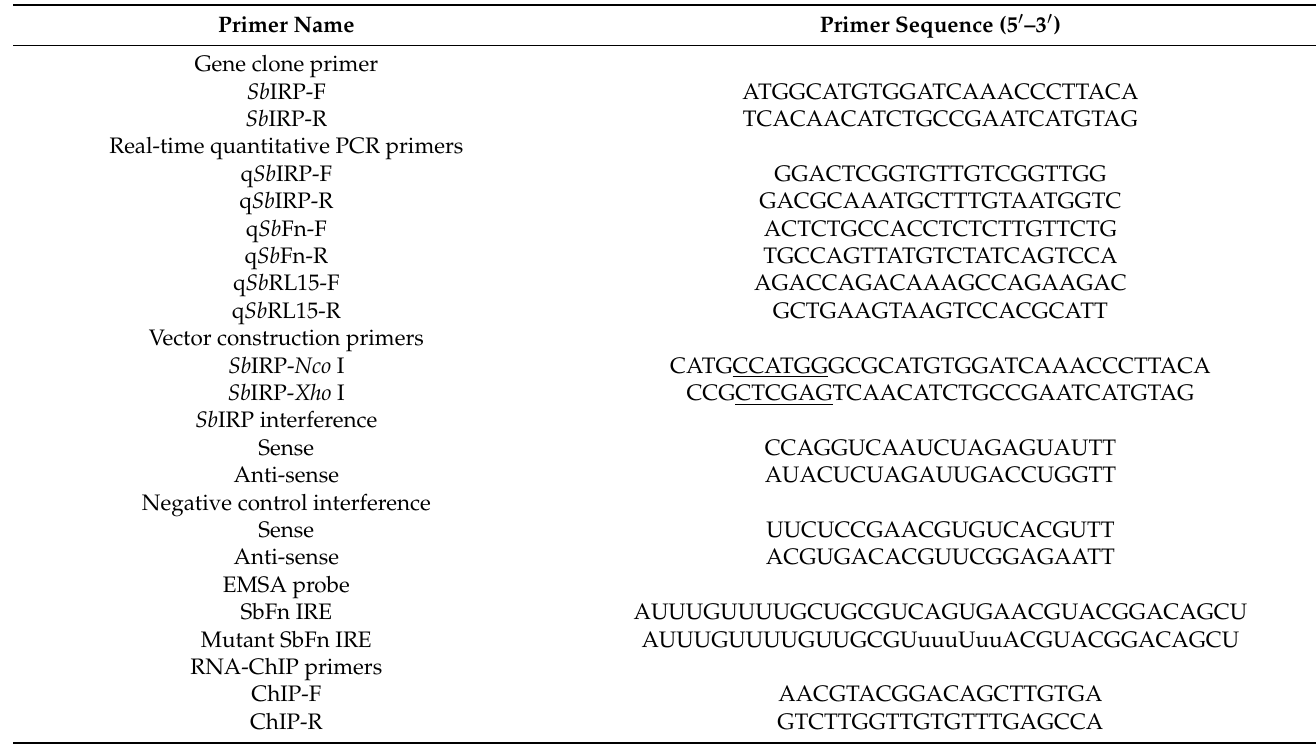
Table 1. The Information of Sequences Used in this